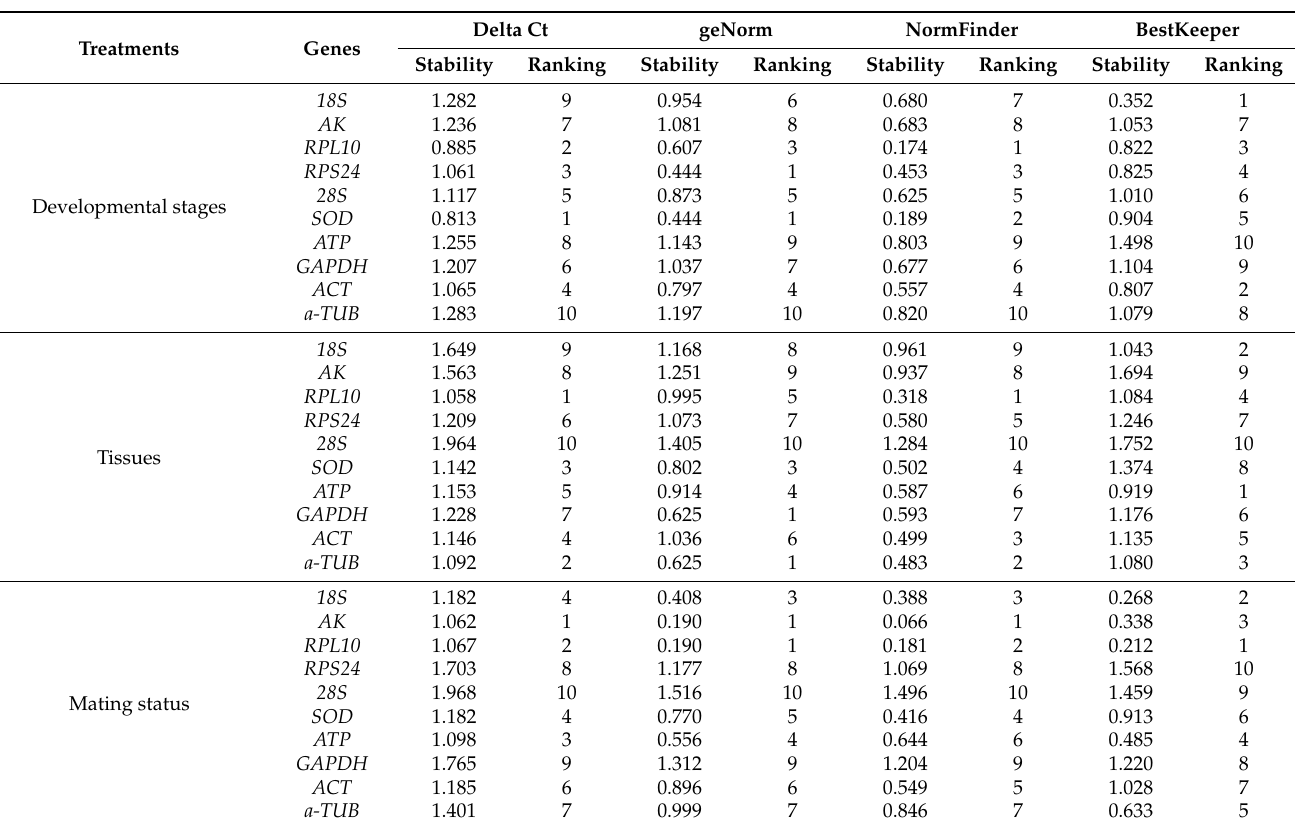
Table 2. Expression stability of 10 candidate reference genes of S. frugiperda in different developmental stages, tissues, and mating status. Treatments Genes